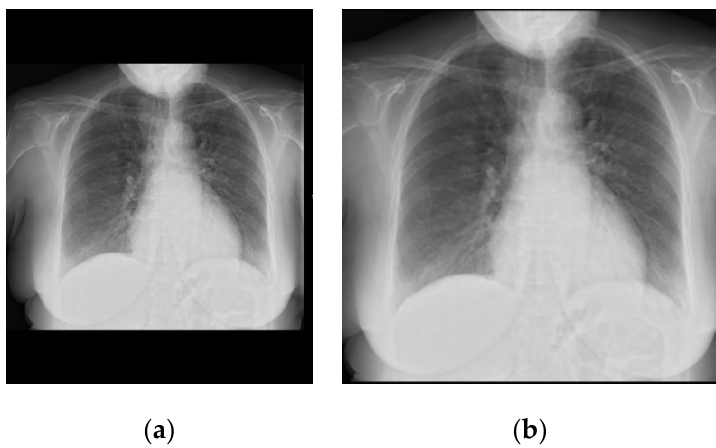
Figure 6. Preprocessing applied to all images of the datasets. ( a ) Shows the original CXR from a patient with COVID-19 (https://github.com/ieee8023/covid-chestxray-dataset); ( b ) shows the preprocessed image to a squared shape. Original images are from (https://github.com/ieee8023/covid-chestxray- dataset).